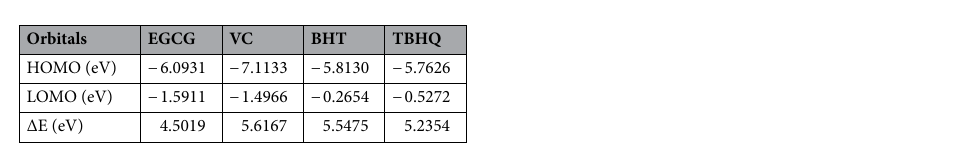
Table 6. Antioxidant frontier orbital levels (HOMO, LUMO) and energy gap (eV).